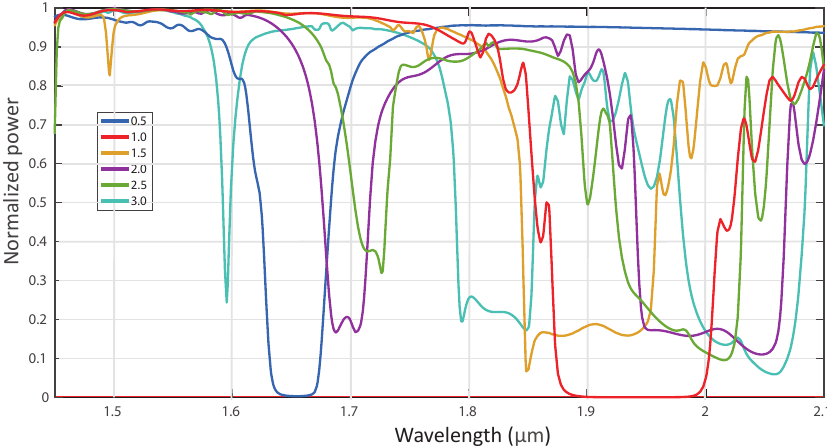
Figure 7. Square-lattice waveguide structures with e 0.5,1.0,1.5,2.0 air-hole columns, respectively, at each side of waveguide cores ( Period = 0.43 µ m)